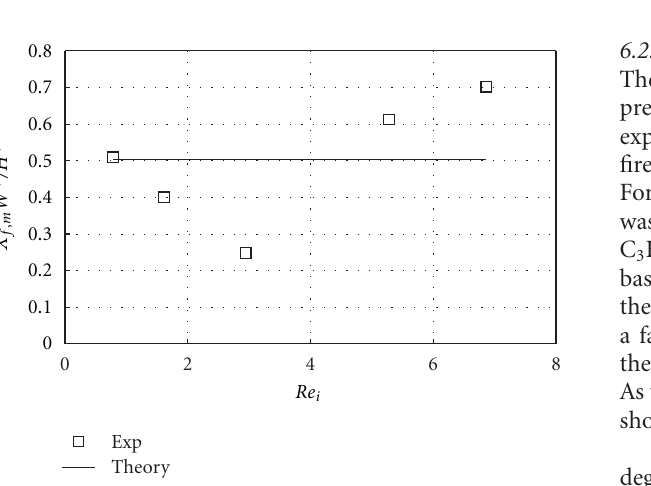
Figure 12: Ratio of axial location of the maximum flame width to the visible flame height as a function of injection Re i for 100% CH 4 fuel.